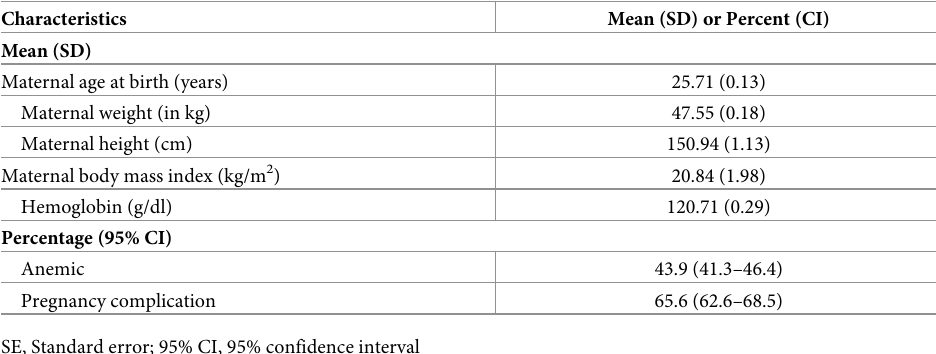
Table 1. Study population characteristics (N =